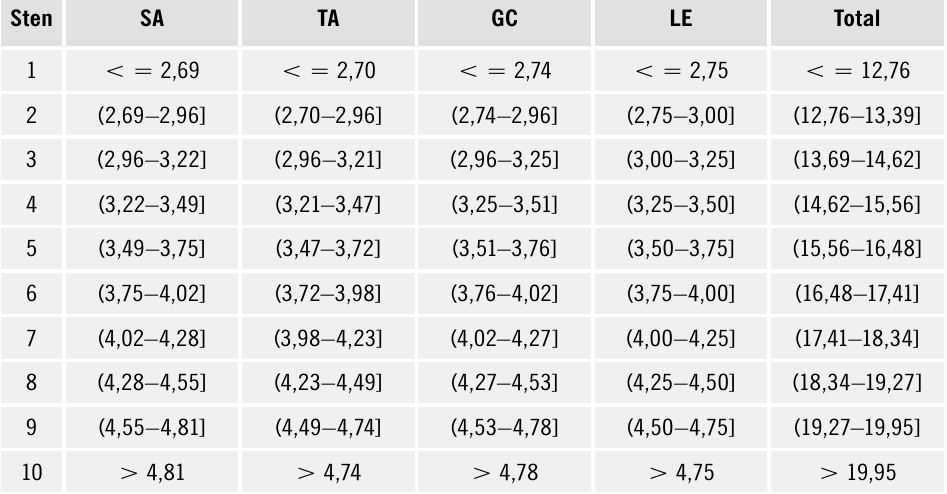
Table 1. Initial normalisation of the scales